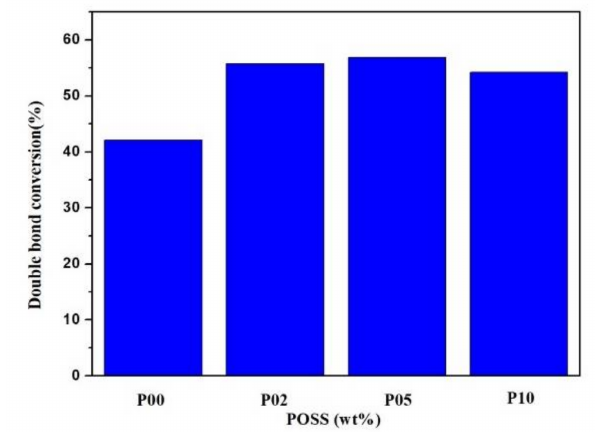
Figure 4. Double bond conversion of composite resins with different POSS